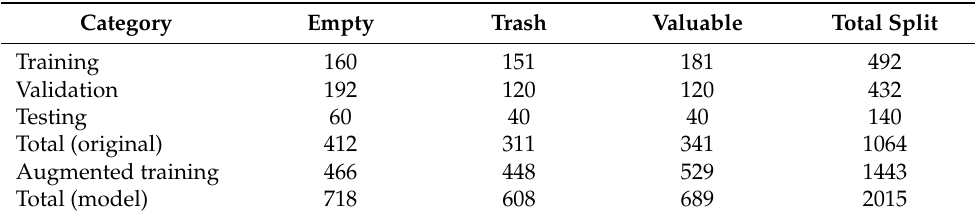
Table 1. Categories of the images within the compiled dataset and their respective quantita- tive compositions.